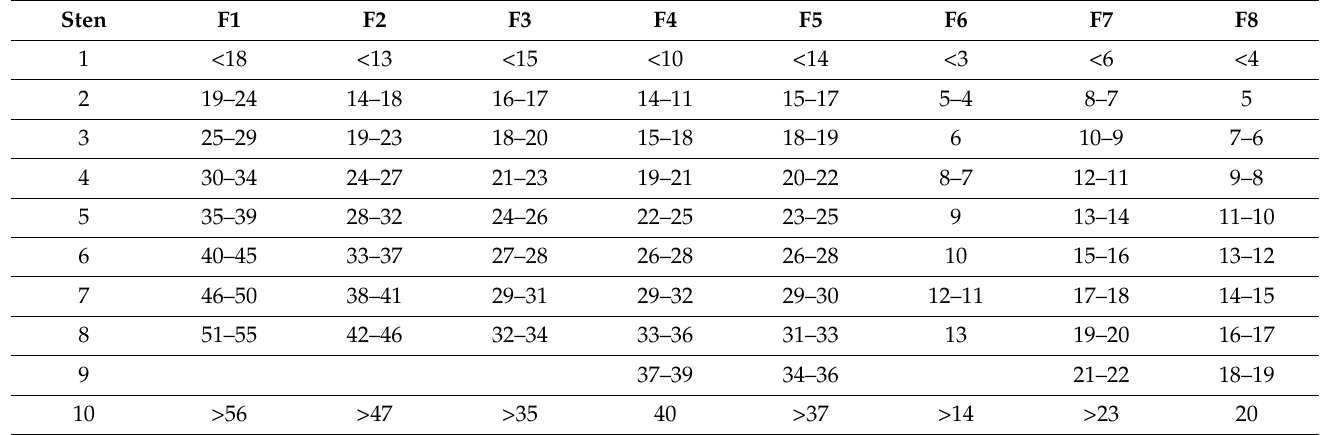
Table 7. Standards of the MBSRQ-PL questionnaire in the group of women.